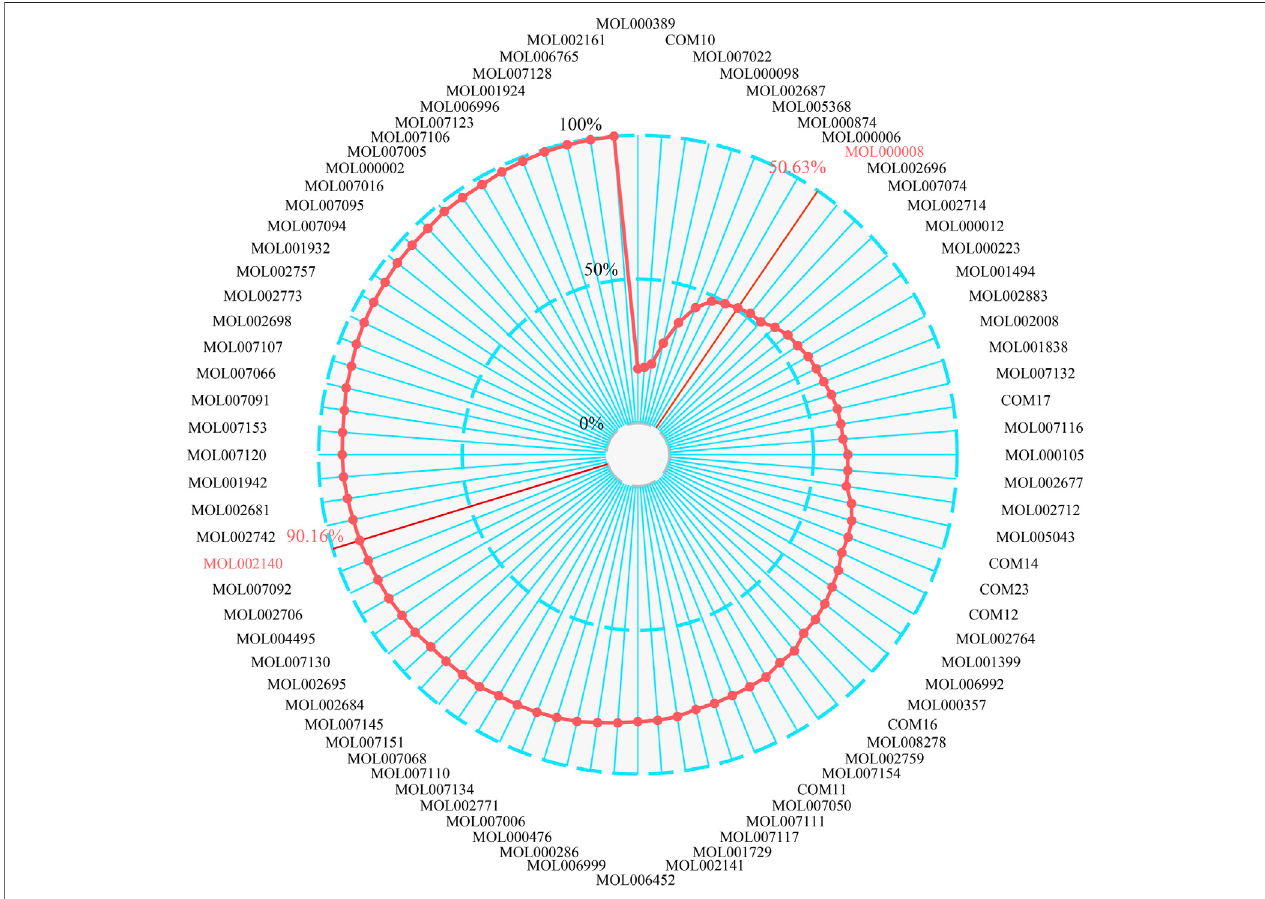
FIGURE 7 | The ICP and accumulative ICP of active ingredients in